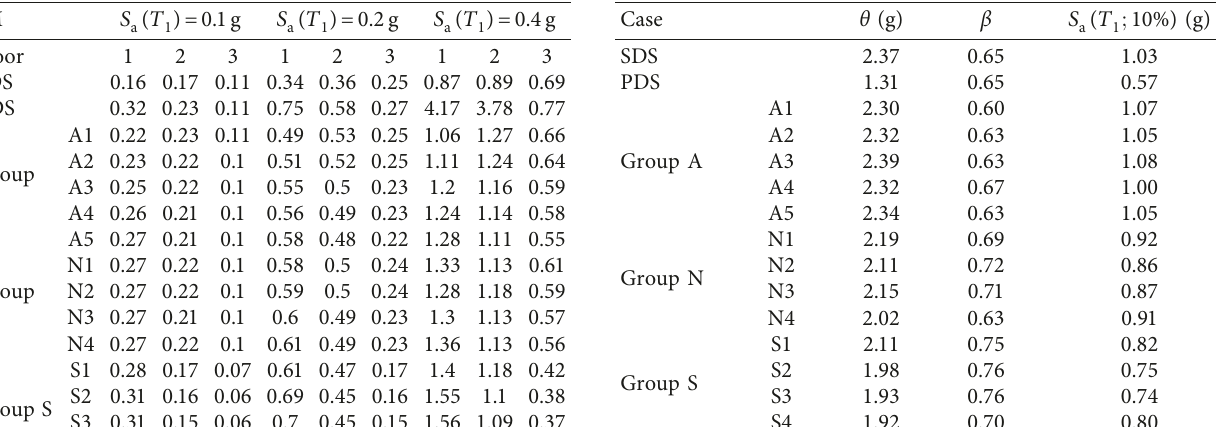
Table 4: Peak interstory drift ratio/%. Table 5: Parameters of the fragility